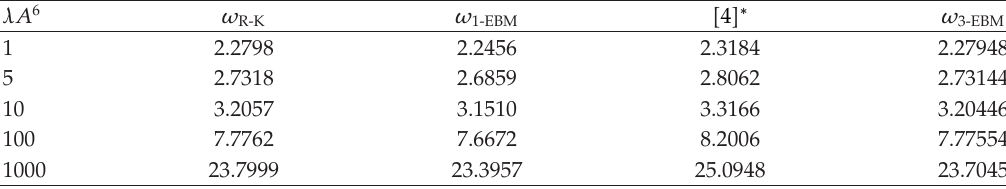
∗ First-order approximation, ω